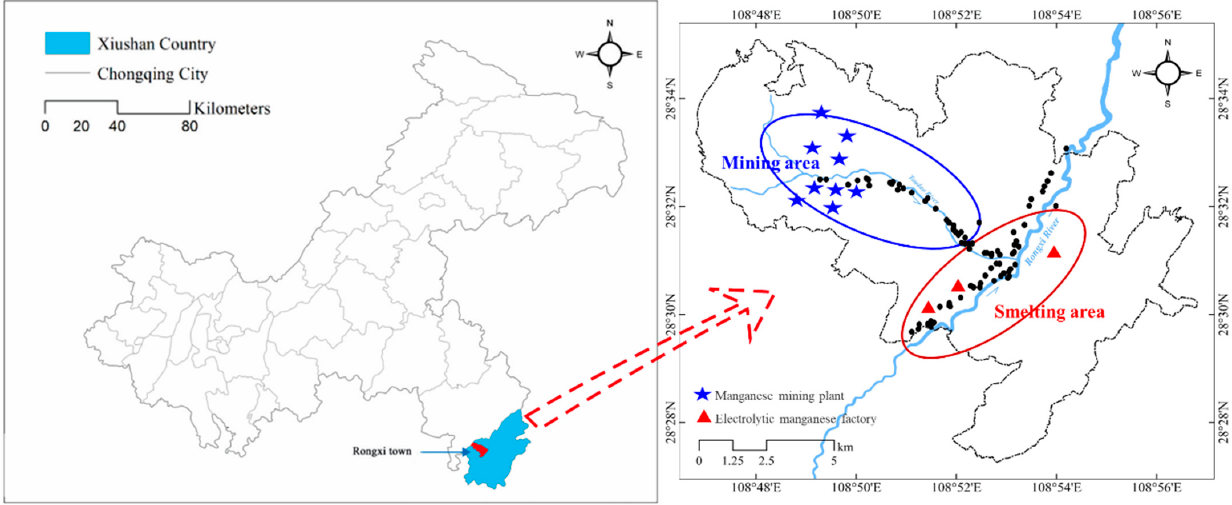
Figure 1. Sampling sites in the Mn mining and smelting areas.